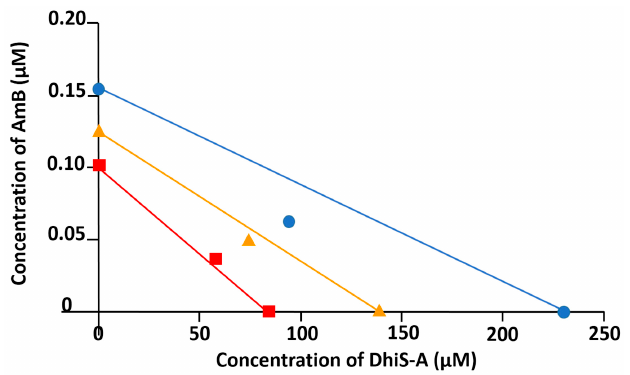
Figure 3. Isobologram of the interaction of AmB with DhiS-A at a fixed concentration ratio (0.01:15). Lines intersect at the x and y axes at concentrations corresponding to EC50 ( ■ ), EC75 ( ▲ ) and EC90 ( ● ). The same symbols are used for the concentration found for the combination of AmB + DhiS-A to elicit the same effect as the drugs added alone. EC: effective concentration.